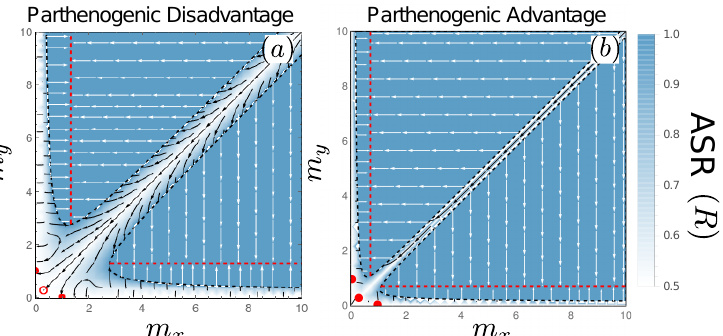
Figure A2. Evolutionary Dynamics under Mixed Sexual and Parthenogenic Reproduction, plotted over a larger range of state-space. Panel ( a ) uses the same parameters as in Figure 4a, while Panel ( b ) uses the same parameters as in Figure 4b.